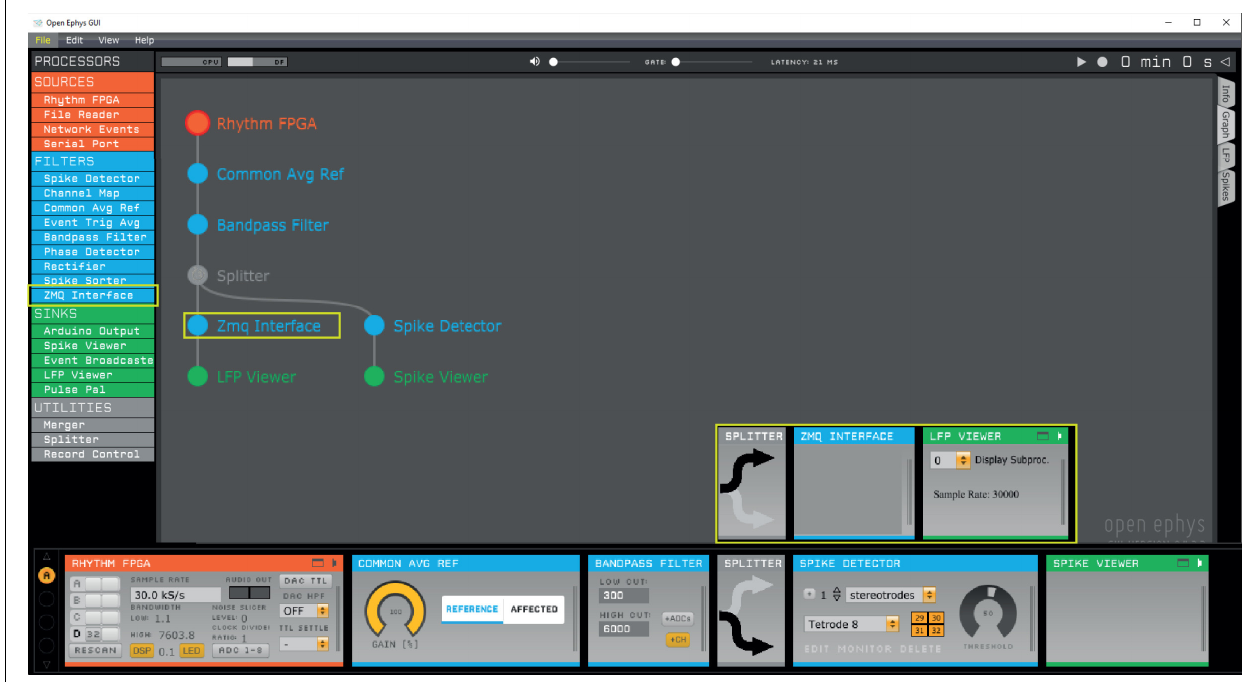
FIGURE 1 | Open Ephys signal chain used to produce the data presented in this study. First, a common average reference filter is applied on the rhythm FPGA data source to remove noise that is common across the electrodes. Next, a band-pass filter rejects low frequency components irrelevant for spike detection. For instance, band-pass filtering between 600 and 6000 Hz enables threshold-based spike detection. Our Python interface implements thresholding itself, therefore, a Spike Detector plug-in should not be included before the ZMQ interface. The ZMQ interface (yellow box), which broadcasts the data to make them available for OPETH, is positioned after the band-pass filter and before the LFP viewer, which visualizes filtered continuous data in the Open Ephys GUI. In a parallel channel, the Open Ephys spike detector filter is applied to allow concurrent visualization of spikes in the Open Ephys